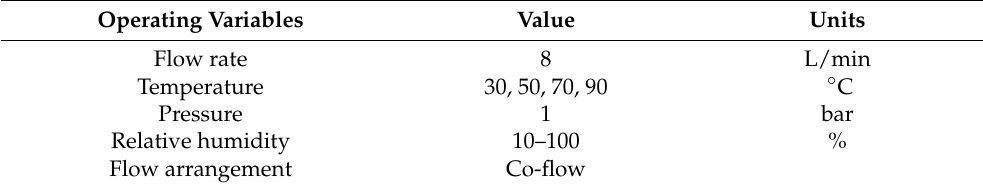
Table 3. Experimental conditions for water-transport through the membrane.